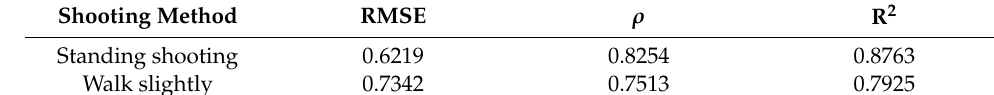
Table 3. Displacement monitoring error of common smartphone shooting methods.